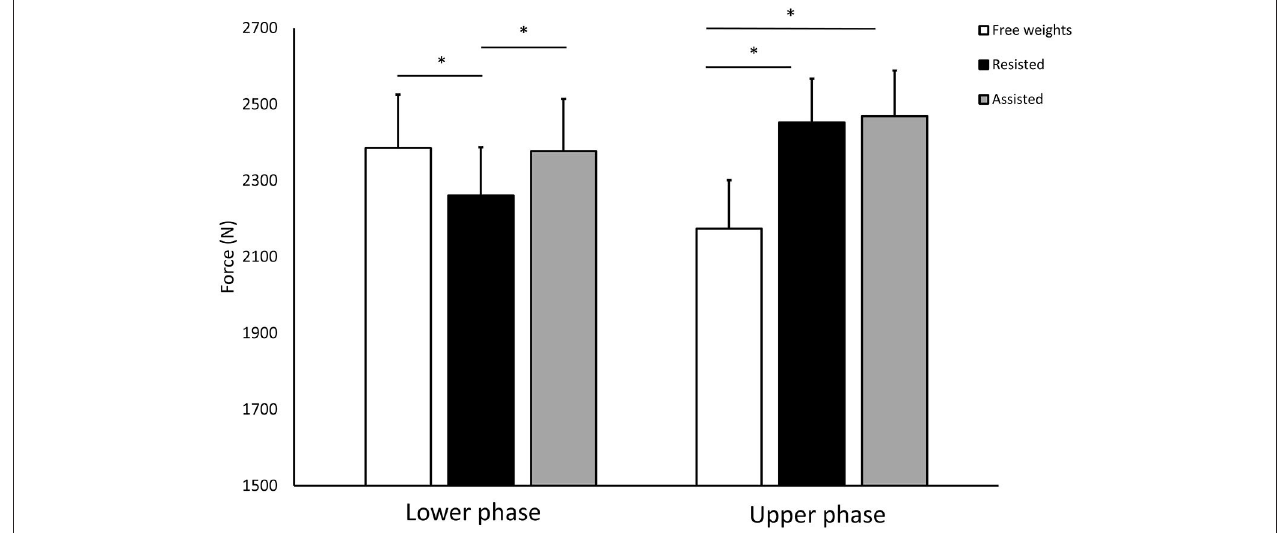
FIGURE 2 | Average force output in the lower and upper phase during the free weights-, resisted-, and assisted deadlift. Values are means and 95% confidence interval. * p < 0.01.